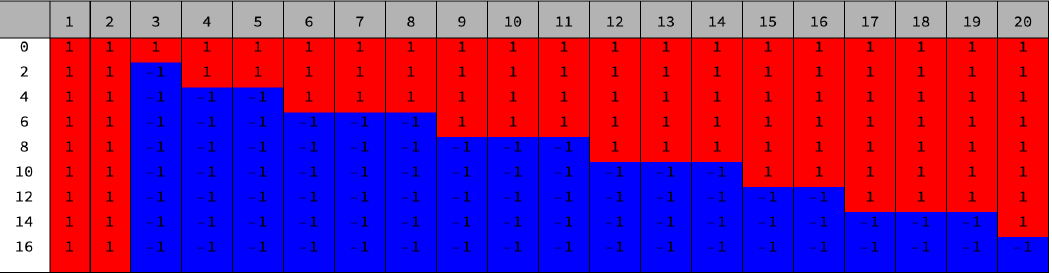
Figure 3. The above grid plots shows the signs of the Feynman block for − 1 ≤ ρ ≤ 1 for 0 ≤ J ≤ 16 and 1 ≤ n ≤ 20 . The red and blue indicate J < J and positive signs